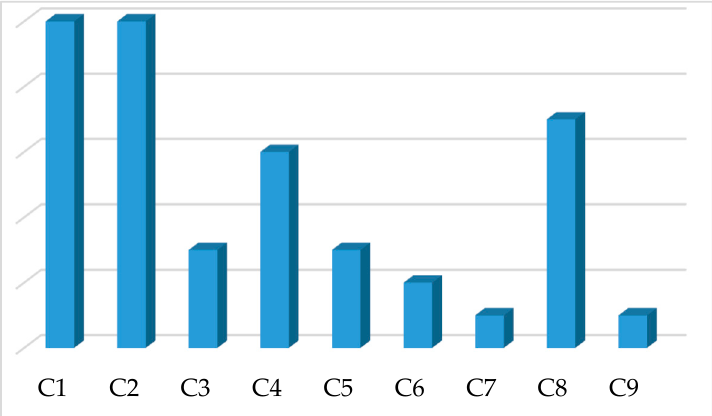
Figure 2. Importance of each criterion after AHP